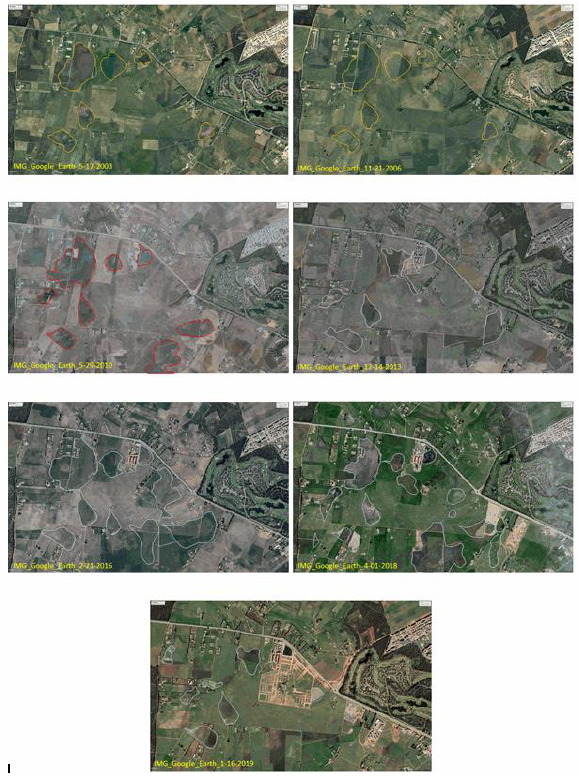
Figure 6 . Temporal and spatial follow-up of the evolution of the urban fabric of the city of Benslimane on the wetlands (dayas).